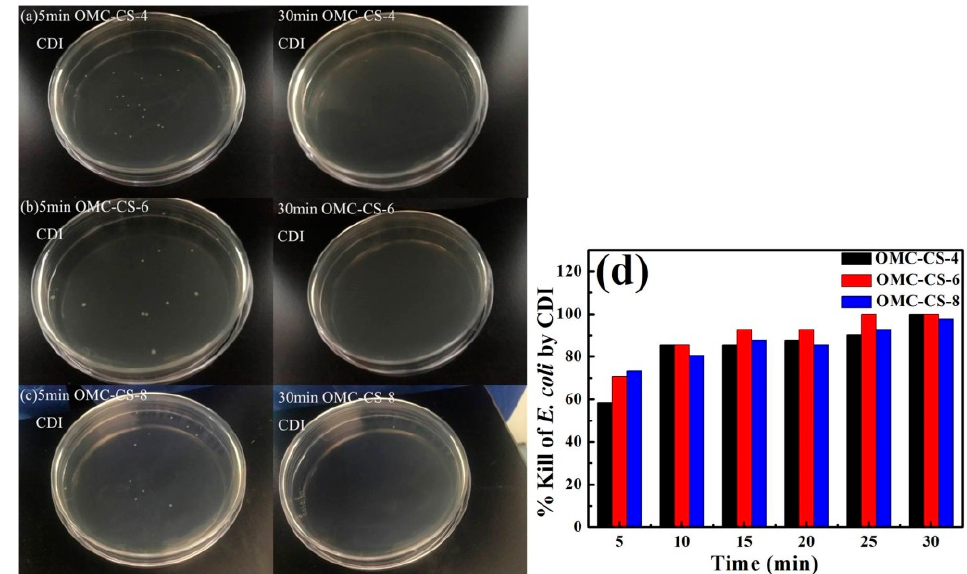
Figure 11. ( a – c ) The colony forming units; ( d ) Killing rate of microbes; after CDI process with OMC-CS-4,6,8 electrodes for 5, 10, 15, 20, 25, 30 min at 10 6 CFU mL − 1 .